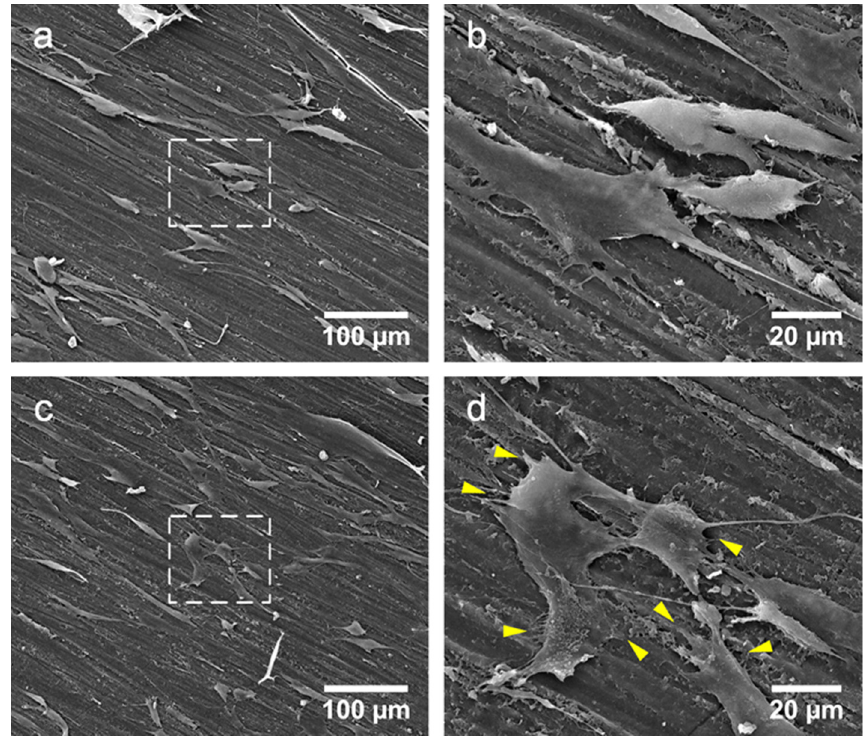
Figure 13. Cell observations on the bone cements before and after the MC modification by SEM: ( a ) cells on unmodified bone cement; ( b ) amplification of the center of Figure 13a; ( c ) cells on MC modified bone cement: and ( d ) amplification of the center of Figure